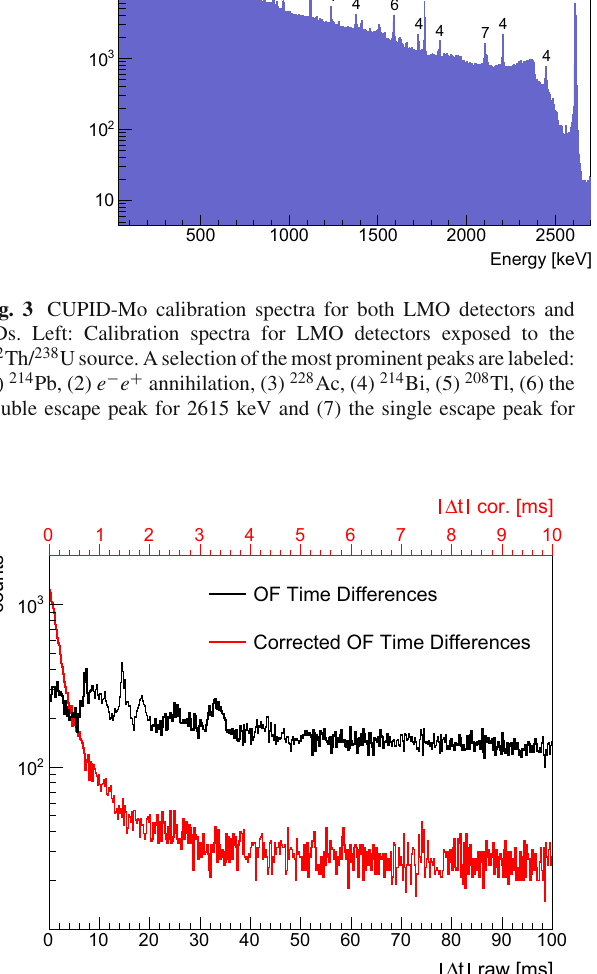
Fig. 4 Time differences for M 2 events whose energy sums to a promi- nent γ peak in calibration data for both raw time (black) and corrected times(red). Note thetimescalesaredifferent inthetwocasestoaccount for the much sharper peak with corrected times. Due to the high event rate in calibration data, an elevated rate of accidental coincidences is present leading to the presence of an elevated flat background in the (cid:9) t